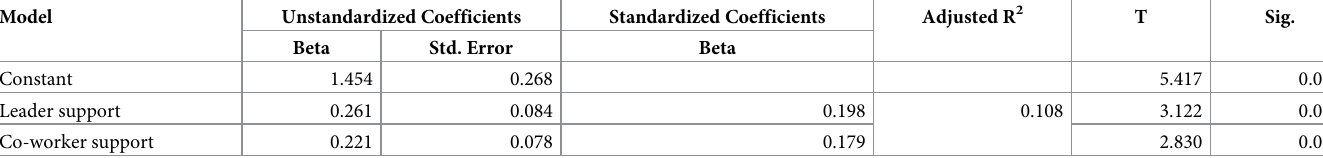
Table 3. Estimation of regression coefficients of the leader and co-workers support and work-family balance.